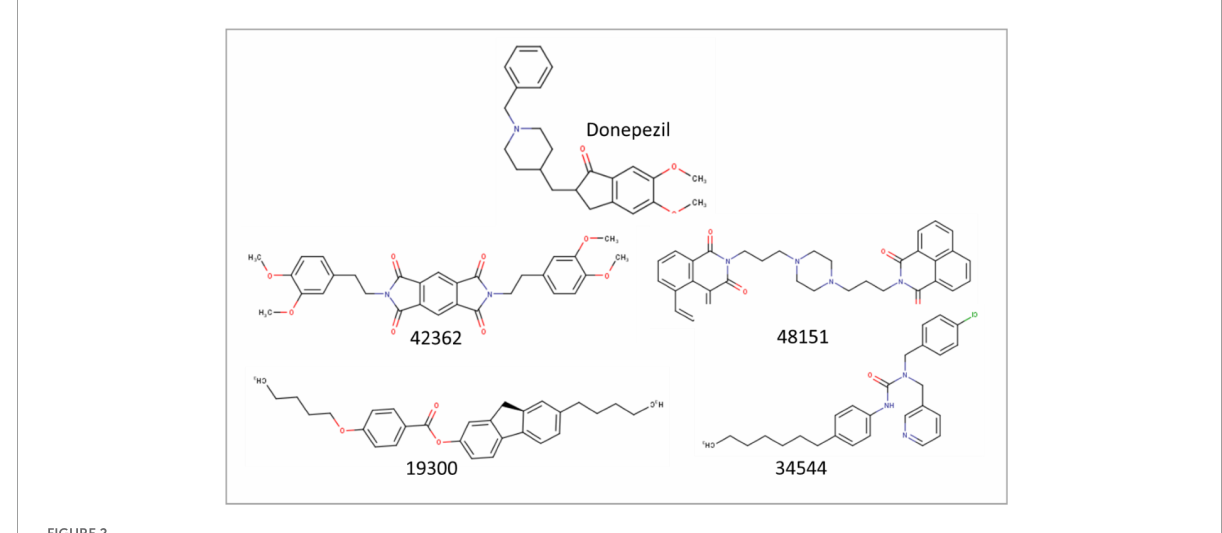
FIGURE2 Stick representation of the 2-dimensional structure of the top four selected molecules in ligand-based virtual screening.